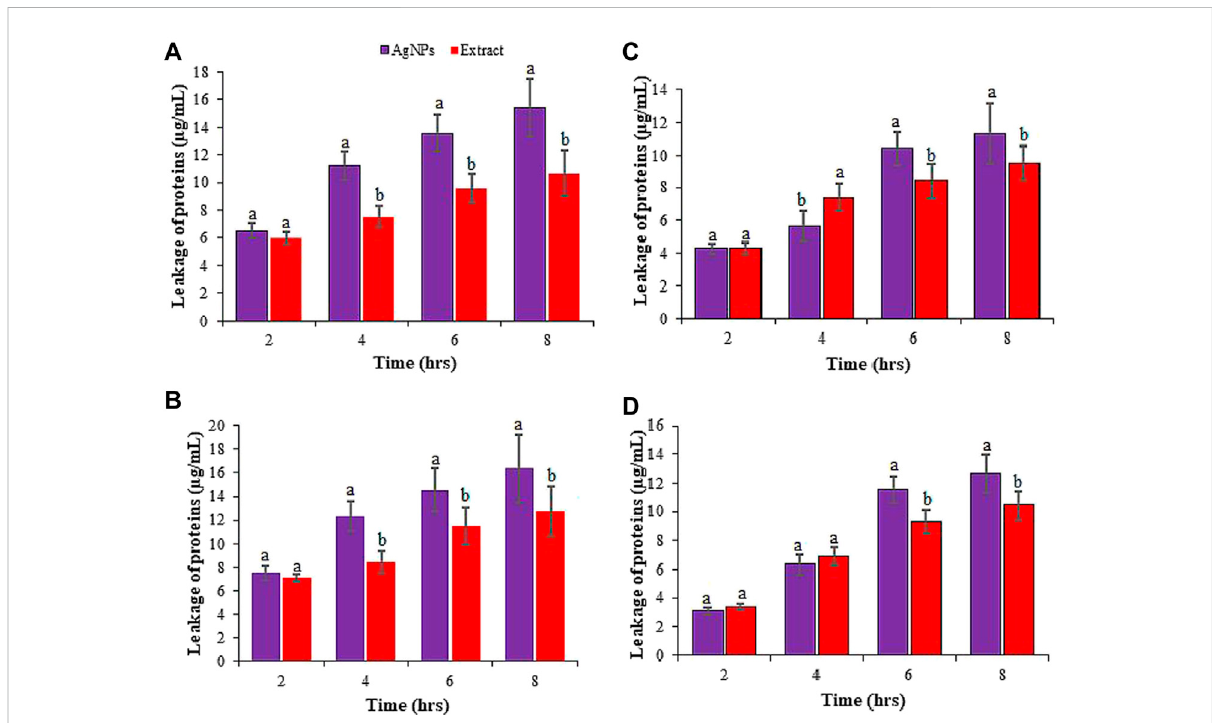
FIGURE 10 Leakage of proteins from (A) E.coli , (B) S. typhimurium , (C) S. aureus , and (D) L. monocytogenes cells treated with Rn-AgNPs. Different letters denote signi fi cant difference ( p ≤ 0.05) between AgNPs and RLE at that particular